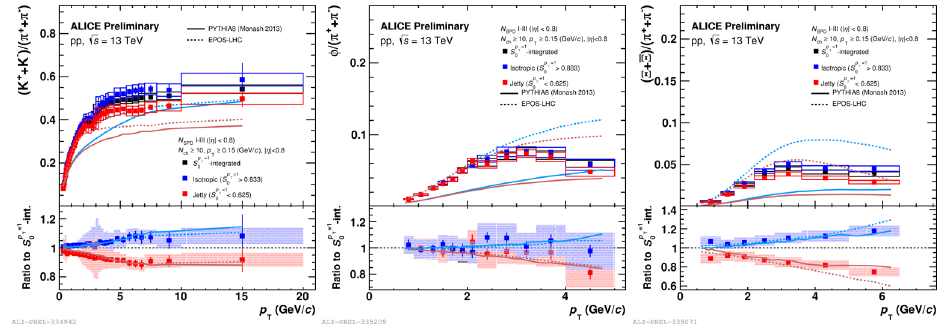
Figure 1: K -to- π (left), φ -to- π (middle) and Ξ -to- π (right) ratios as a function of p T in bins , for Jetty (red), Isotropic (blue), and S p T = 1 -integrated (black) events. Lower panels of S p T = 1 O O show the ratios to S p T = 1 -integrated. The results are compared to predictions from PYTHIA8- O Monash (solid lines) and EPOS-LHC (dashed